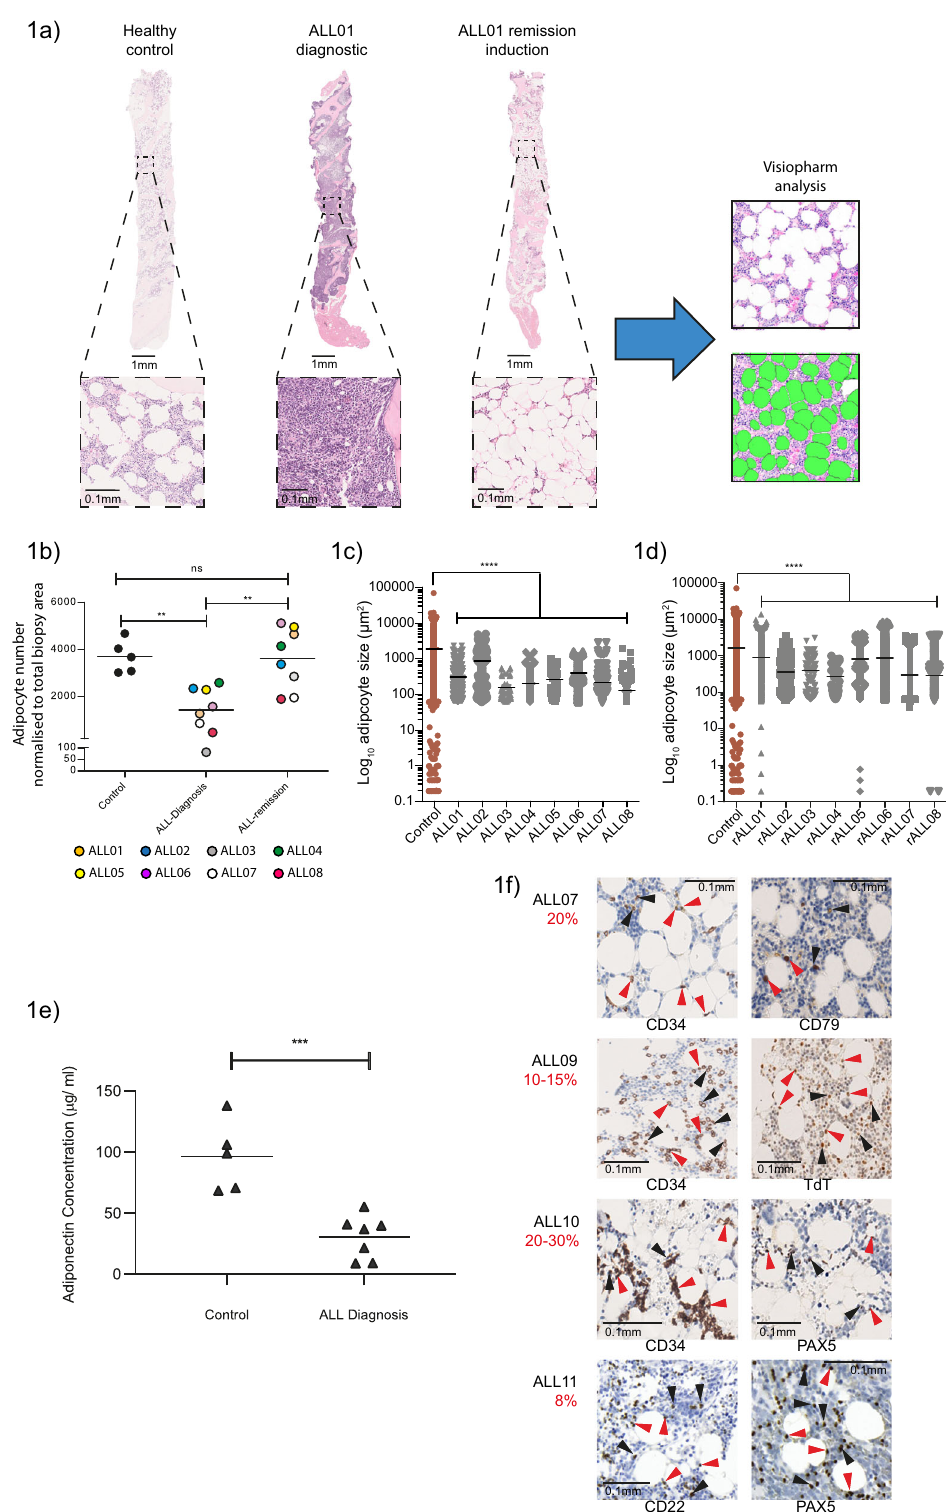
permitted functional assessment of clonogenic capacity. We observed a nonuniform growth response in ALL-MSCs, re fl ecting expected differences in tumour and host biology. We therefore dichotomized growth data into high and low performers de fi ned by the mean number of ALL-MSCs (Fig. 2a). High performers constituted a small subgroup (3/12, 25%) whose growth activity and CFU-F were indistinguishable from healthy